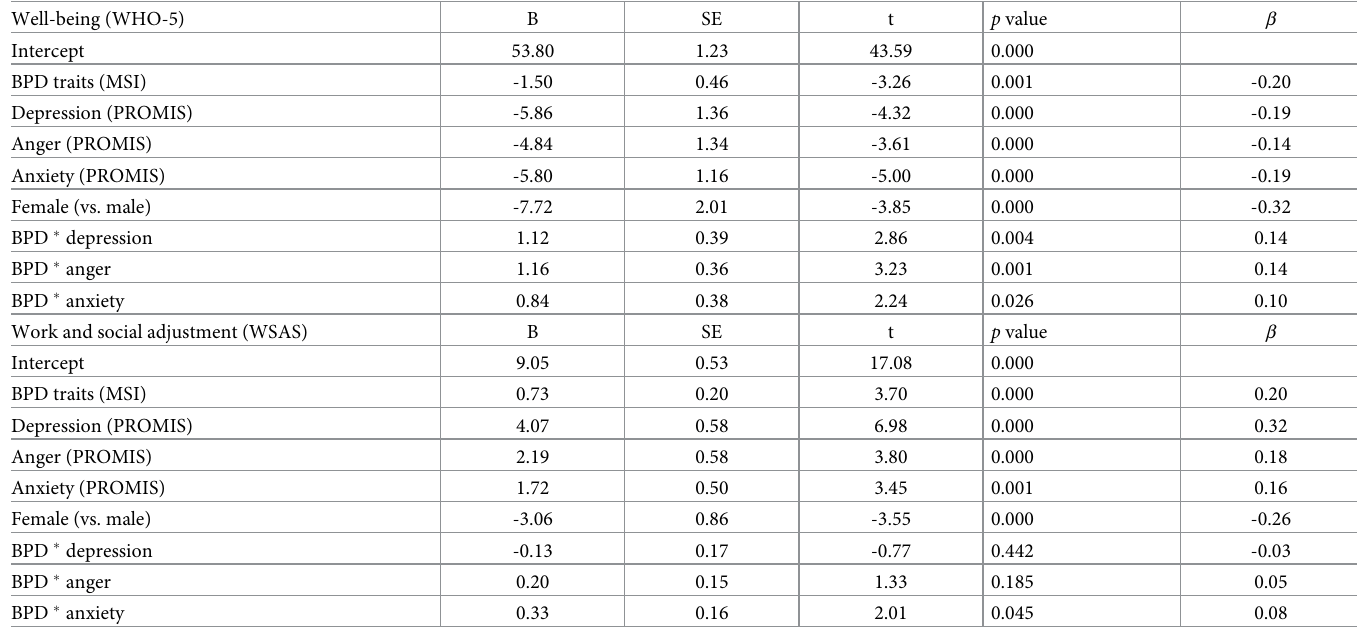
Table 4. Interactions between depression, anger, and anxiety and borderline traits in predicting well-being and work/social adjustment (n = 471). Well-being (WHO-5) B